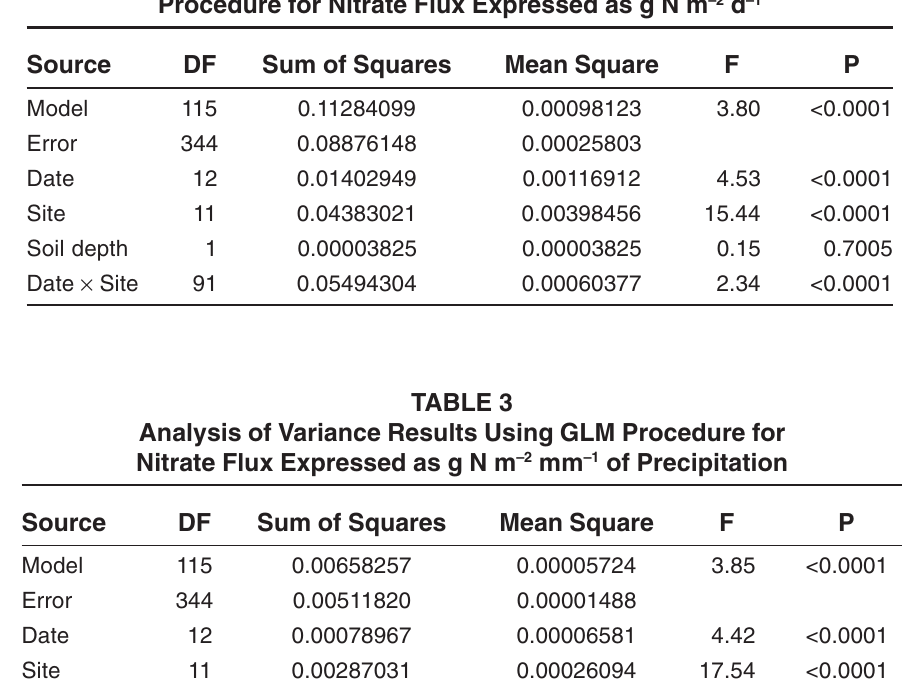
Analysis of Variance Results Using